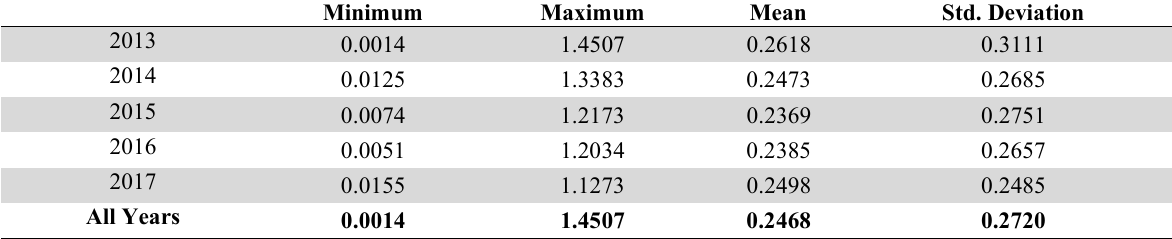
Descriptive analysis of earnings